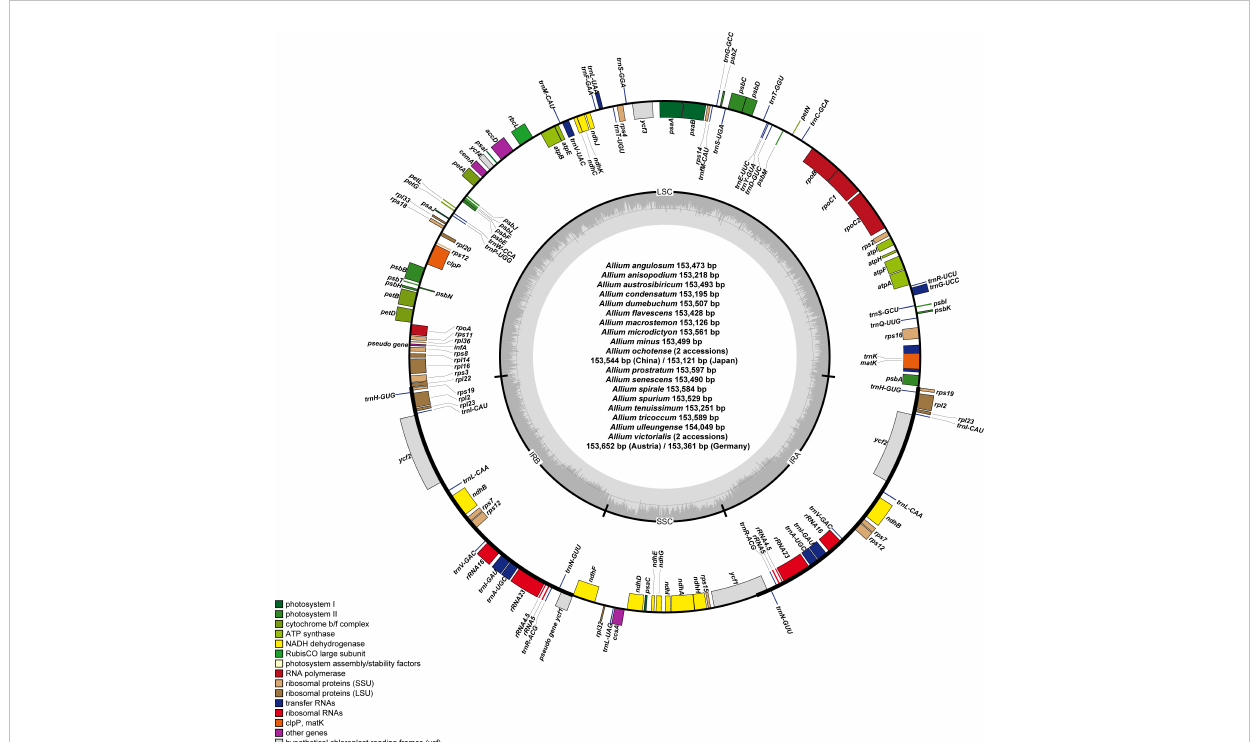
FIGURE 2 Complete plastome map of newly sequenced Allium species (a total of 20 accessions from 18 species) sequenced in this study. The genes inside and outside of the circle are transcribed in the clockwise and counterclockwise directions, respectively. Genes belonging to different functional groups are shown in different colors. The thick lines indicate the extent of the inverted repeats (IRa and IRb) that separate the genomes into small single copy (SSC) and large single copy (LSC)